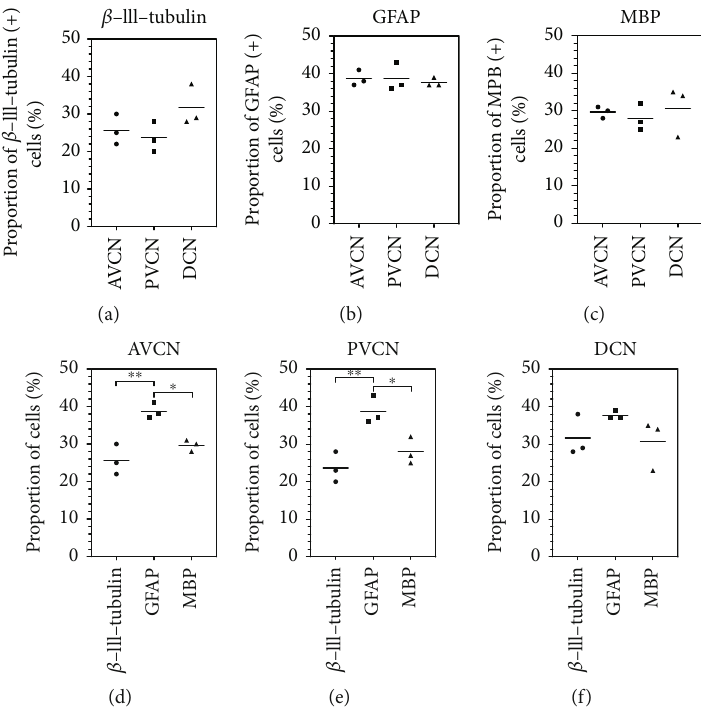
Figure 4: Propagated stem cells of all subnuclei express markers of the neuroectodermal lines after an eight-day di ff erentiation phase. It was examined whether there are relevant di ff erences in di ff erentiation in cultures of the di ff erent regions. The marker β -III-tubulin identi fi es neuronally di ff erentiated cells. Astrocytes show expression of GFAP, and oligodendrocytes can be identi fi ed immunohistochemically by MBP. (a) AVCN, PVCN, and DCN showed, on average, 26-32% β -III-tubulin-positive neurons (mean; n = 3 ). (b) The majority of the cells were glial di ff erentiated and GFAP positively stained (38-39%) (mean; n = 3 ). (c) MBP-positive labeled oligodendrocytes were present in 28-31% of the cells of the subnuclei (mean; n = 3 ). There were no signi fi cant di ff erences in the rates of neural stem cell di ff erentiation between the CN subnuclei. (d – f) Intraindividual analysis of the relations of di ff erentiation markers. Signi fi cant variances in di ff erentiation were found in progenitor cells from AVCN and PVCN. Most of the cells expressed the glial cell marker GFAP, followed by oligodendrocytes (MBP). The smallest part of the cells showed neuronal di ff erentiation with β -III-tubulin expression. The same tendency emerged in the area of the DCN. Box plots show the median with the upper and lower quartiles, and whiskers mark the upper and lower maximum values; asterisks indicate the signi fi cance level: ∗ p < 0 : 05 , ∗∗ p < 0 : 005 , ∗∗∗ p < 0 : 001 , and ∗∗∗∗ p < 0 : 0001